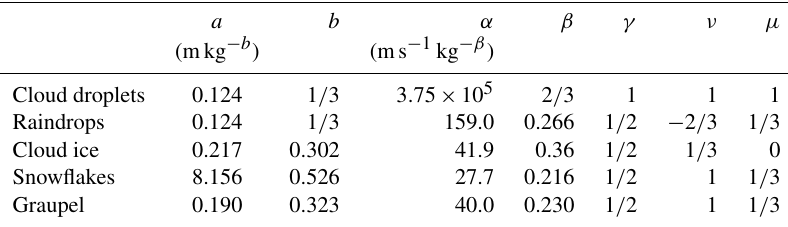
Table B1. Overview of setting microphysical parameters for